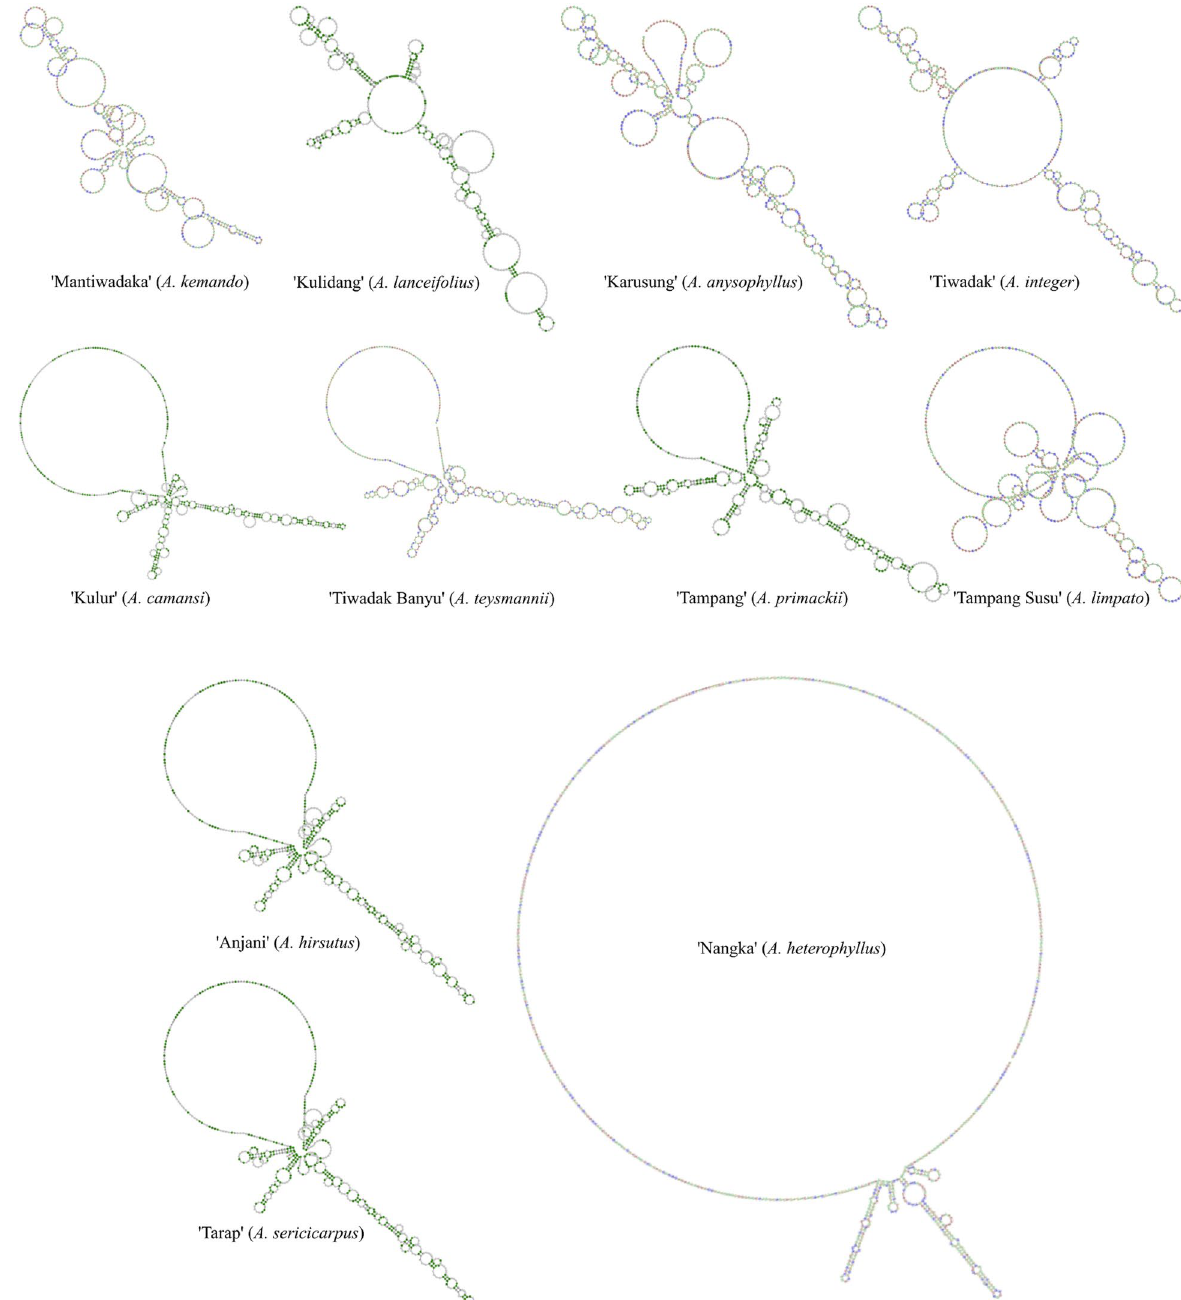
Fig. 5 The secondary structures of the breadfruit ( Artocarpus spp.) ITS sequence endemic to South Borneo, Indonesia, shows different forms. In this case, ‘Anjani’ ( A. hirsutus ) and ‘Tarap’ ( A. sericicarpus ) have